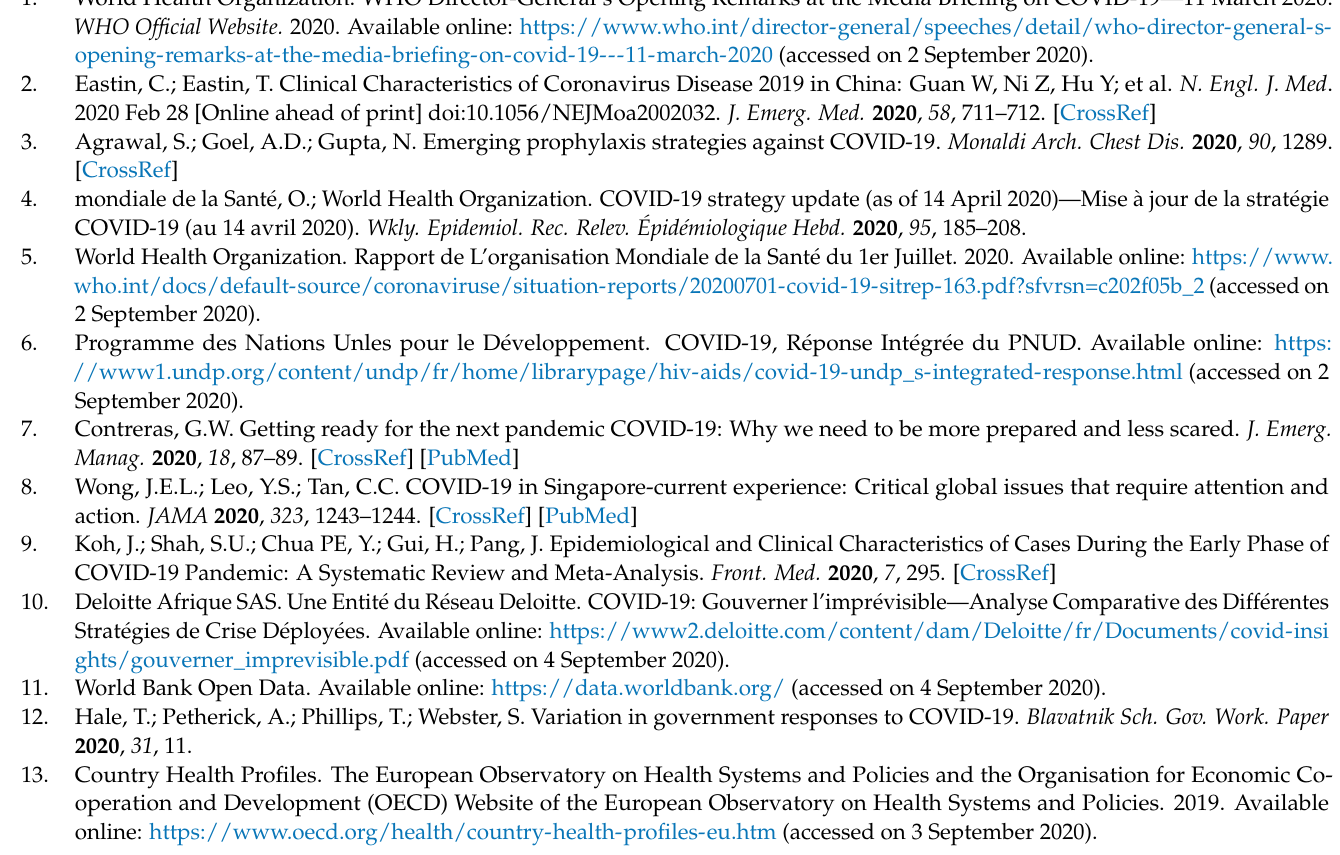
territorial movements, Table S6: Indicator 1.15 Restrictions on gatherings, Table S7: Indicator 3.4 Testing strategies, Table S8: Indicator 4.2 Management of international travel, Table S9: Indicator 6.2 Contact tracing